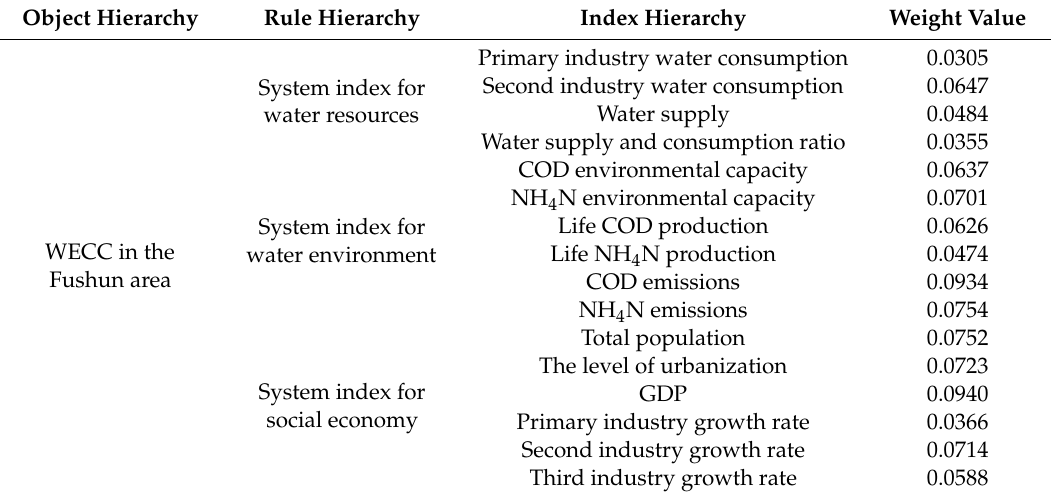
Table 1. Weights values of the evaluation